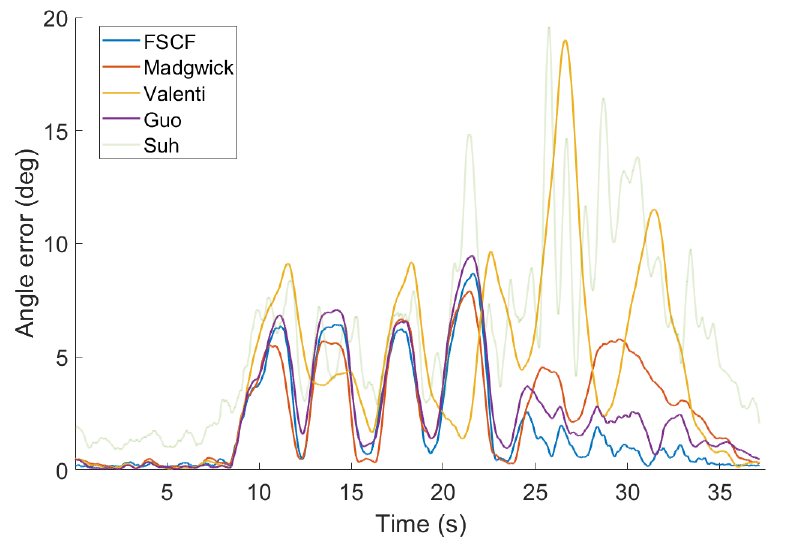
Figure 7. Error of the tested filters for data from the first scenario. Parameters of all filters were tuned for best overall (scenario 3) performance.